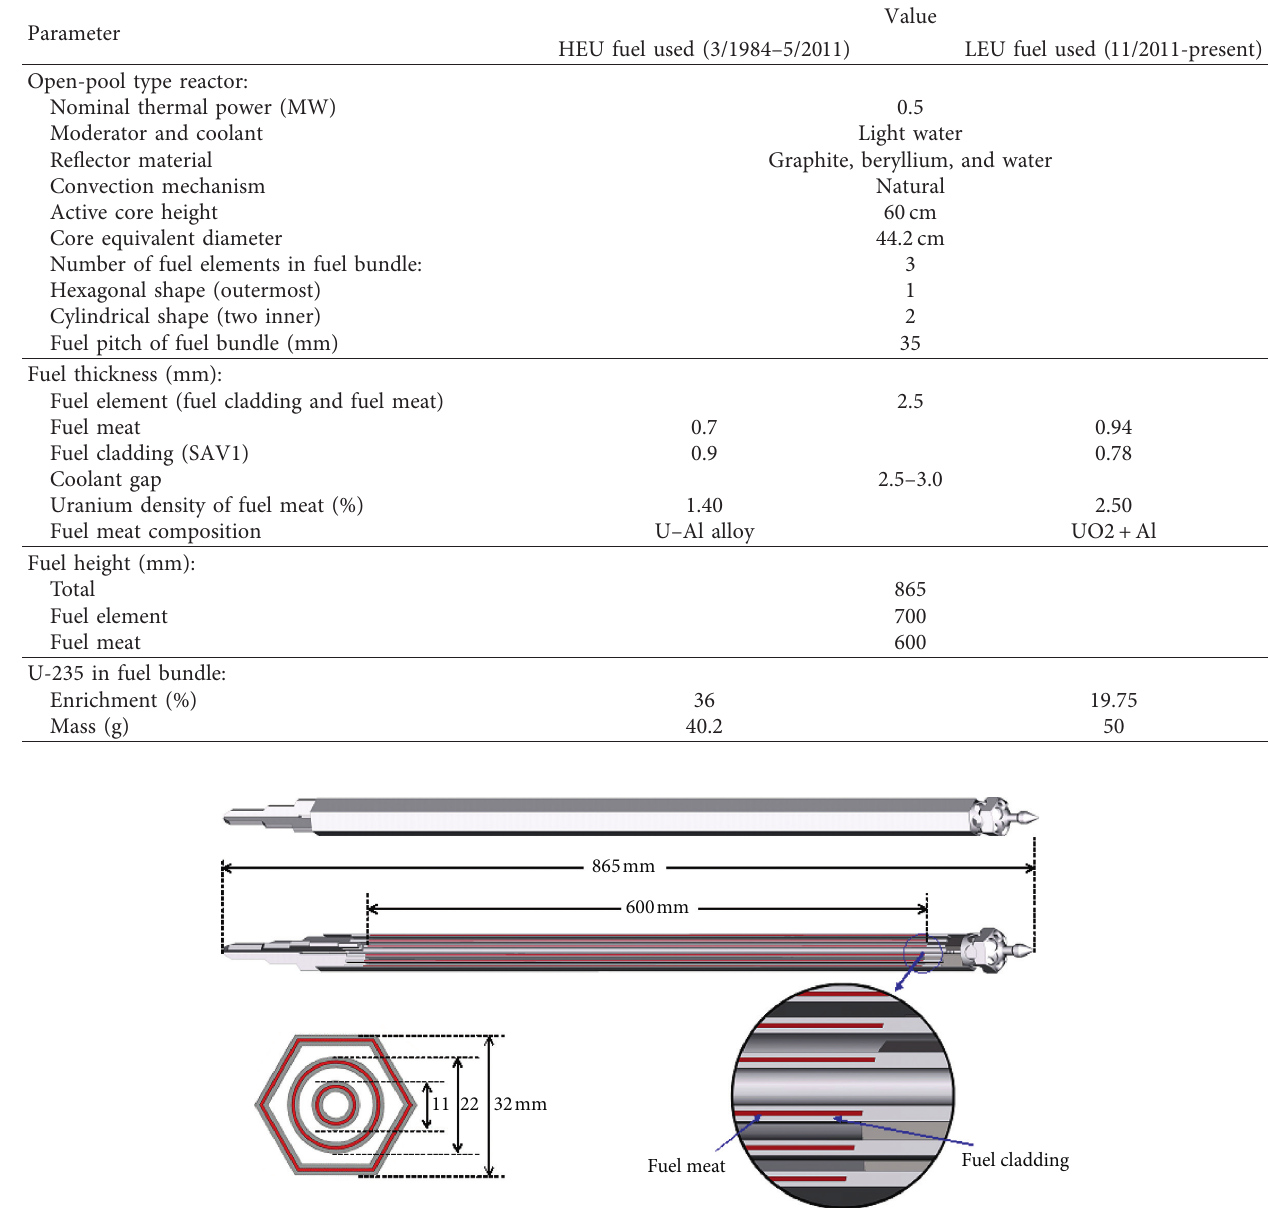
Figure 1: VVR-M2 fuel bundle